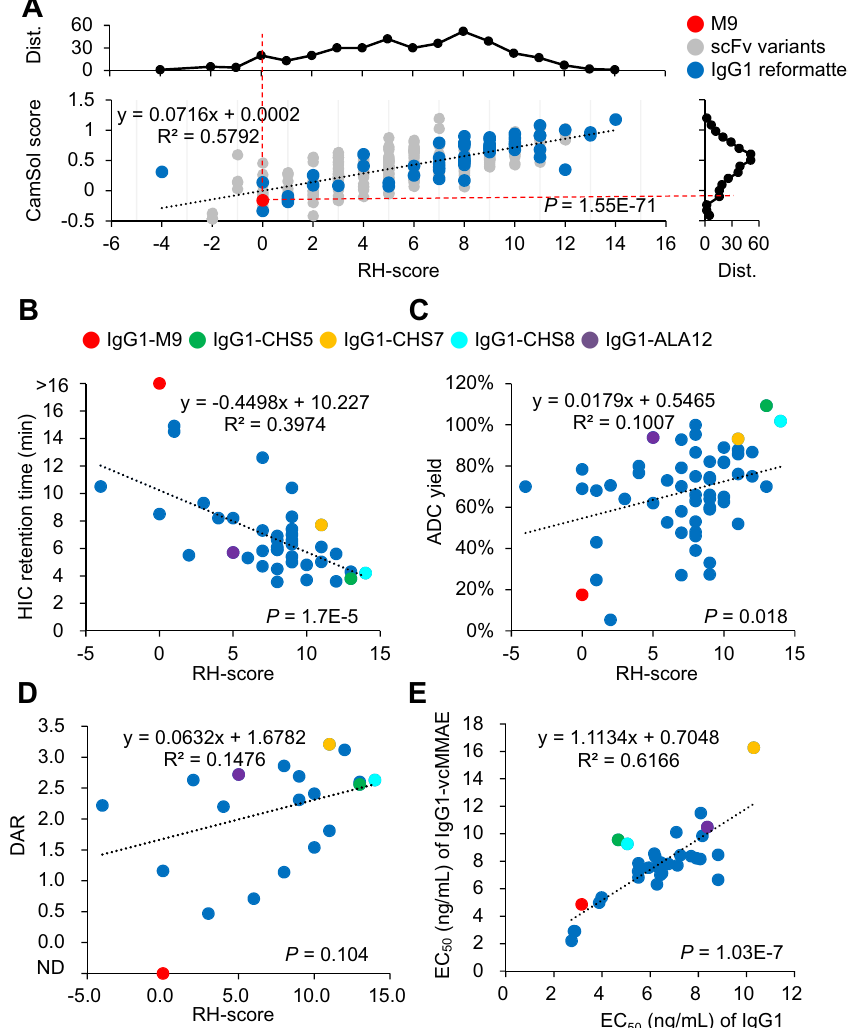
Figure 4. Characterization of the ADC preparations for IgG1-vcMMAE. ( A ) The grey and blue data points in the scatter plot are the CamSol scores 36 (y-axis) plotted against the RH-scores (x-axis) for the MSLN-positive scFv CDR-variants of M9 shown in Fig. 3 (sequences are listed in Supplementary Table S1). The data point for scFv-M9 is colored in red. The data points for the 55 selected scFv CDR-variants of M9 reformatted with human IgG1 framework are colored in blue. The distribution curve above the scatter plot shows the number of scFv CDR-variant of M9 (y-axis) at each bin of the RH-score (x-axis); the distribution curve at the right-hand side of the scatter plot shows the number of scFv CDR-variant of M9 (x-axis) at each bin of the CamSol score (y-axis). ( B ) IgG1s reformatted from selected scFv CDR-variants of M9 were characterized with hydrophobic interaction chromatography (HIC). The HIC retention times of the IgG1s (y-axis) are plotted versus their corresponding RH-scores (x-axis). The R 2 and the P value in this panel were calculated without including the data point for M9 colored in red. ( C ) ADC yields of the IgG1-vcMMAEs are plotted versus their corresponding RH-scores. ( D ) DARs of the IgG1-vcMMAEs are plotted versus their corresponding RH-scores. The DAR for M9-vcMMAE could not be measured with HIC, as shown in Supplementary Figure S2, and thus the datapoint (colored in red) for the DAR of M9-vcMMAE is indicated by ND in the y-axis. The R 2 and the P value in this panel were calculated without including the data point for M9 colored in red. ( E ) The EC 50 ’s of the IgG1-vcMMAEs binding to MSLN are plotted versus the EC 50 ’s of the IgG1 binding to MSLN. In panels ( B )–( E ), data points